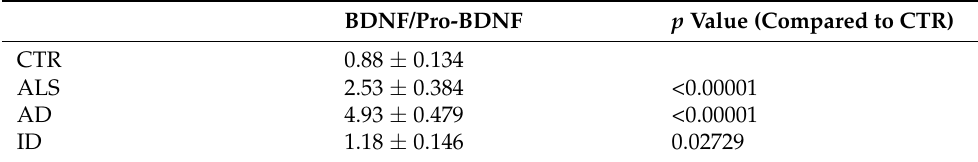
Table 3. BDNF/Pro-BDNF ratio in ALS, AD, ID patients and control subjects.